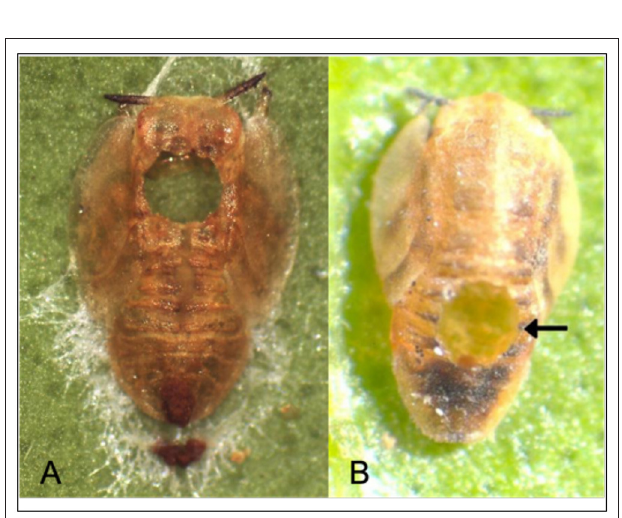
FIGURE 4 | Locations of emergence of the parasitoids Tamarixia radiata and Diaphorencyrtus aligarhensis on “mummified” nymphs of Diaphorina citri (A,B) , respectively.